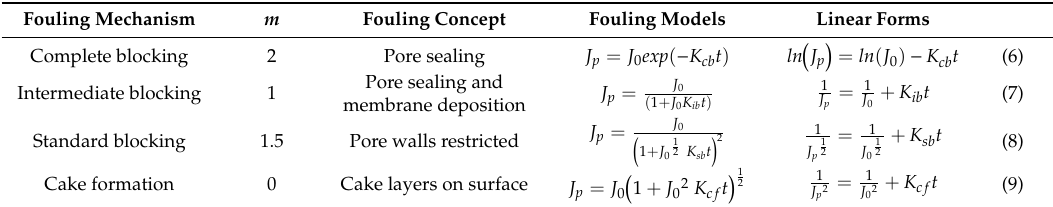
Table 2. Summary of the fouling mechanisms by blocking models during dead-end filtration. Fouling Mechanism m Fouling Concept Fouling Models Linear